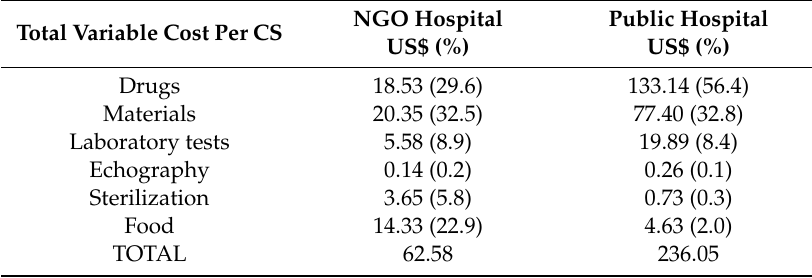
Table 6. Variable Cost (in